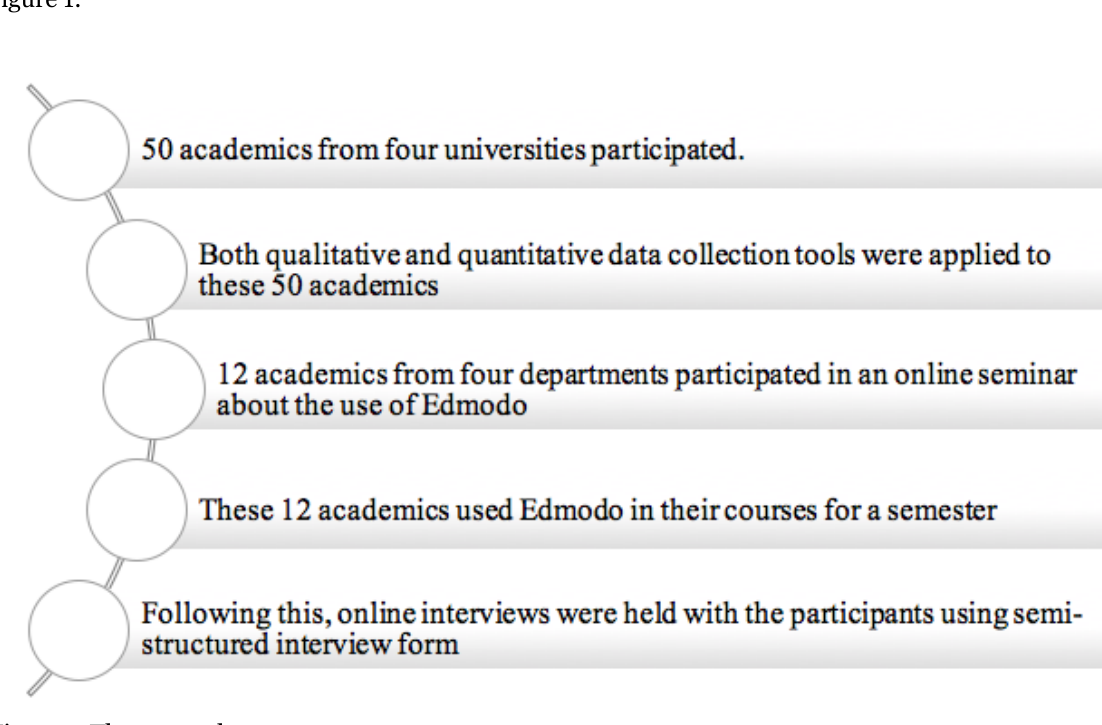
Figure 1. The research